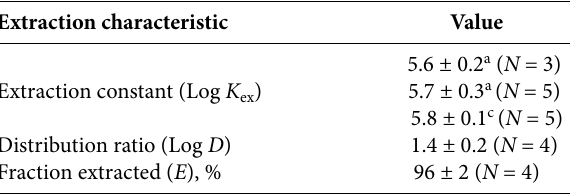
Table 3. Extraction